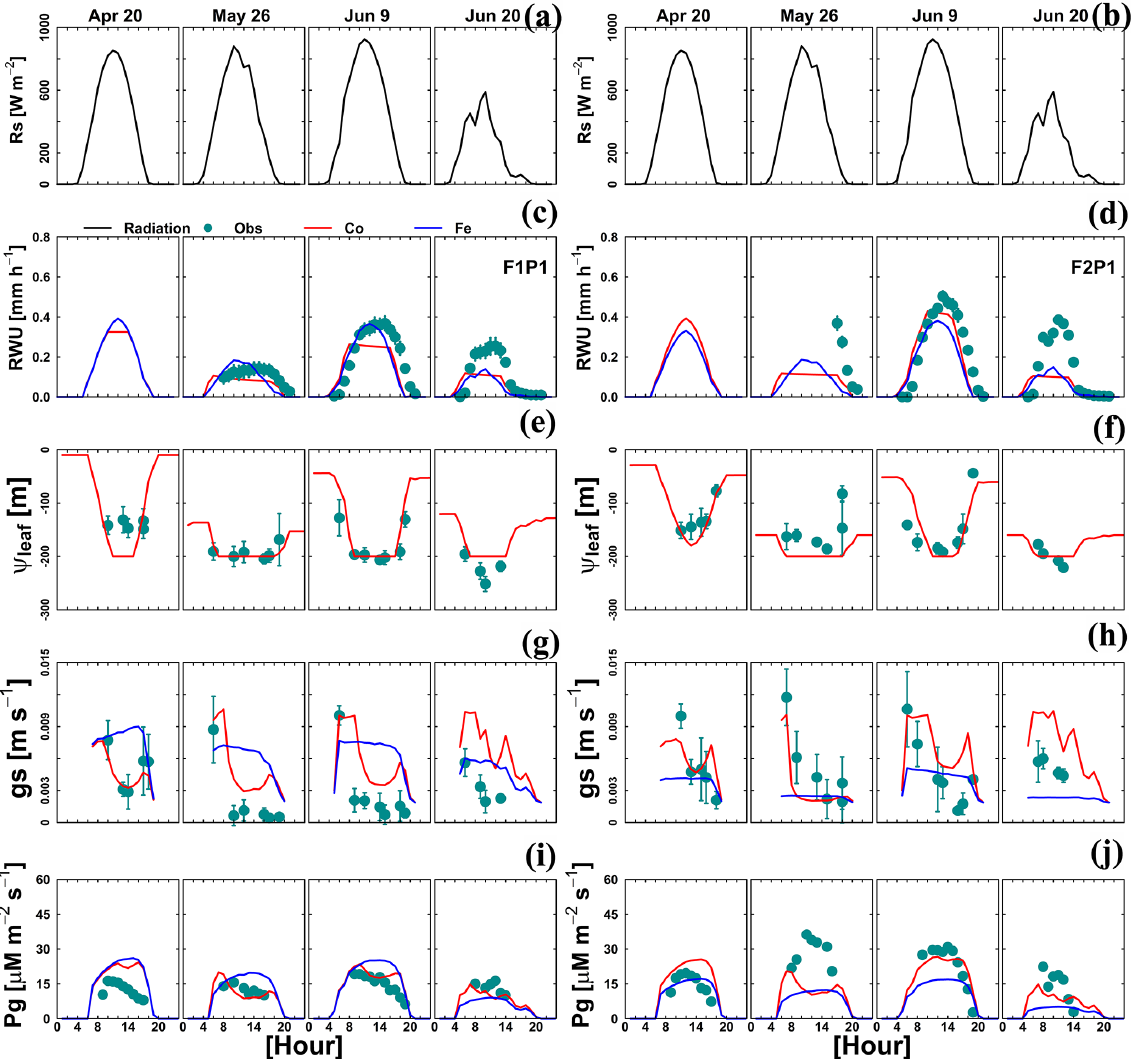
Figure 9. Diurnal courses of 4 selected measurement days: 20 April, 26 May, 9 June, and 20 June 2016. (a, b) Global radiation (Rs), (c, d) actual transpiration (RWU), (e, f) leaf water pressure head ( ψ leaf ), (g, h) stomatal conductance to water vapor ( g s ), and (i, j) gross assimilation rate ( P g ) in the sheltered plot (P1) of the stony soil (F1) and the silty soil (F2). The cyan dots denote the observed values, and the solid red lines and solid blue lines denote the simulated values from the Couvreur model (Co) and Feddes model (Fe), respectively. Sap flow sensors were installed on 26 May 2016 at 09:00 and 17:00LT for F1P1 and F2P1, respectively. Simulated stomatal conductance is from sunlit leaves. The Feddes RWU model did not simulate the leaf water pressure